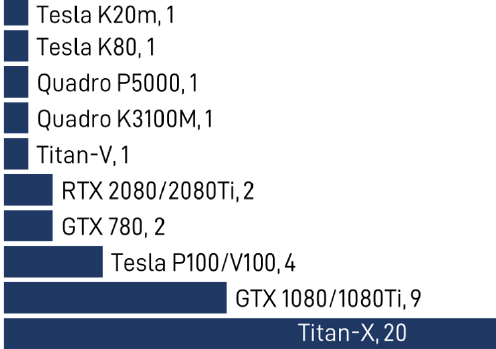
Figure 9. Overview of GPUs used to run the deep learning models. All GPUs are from